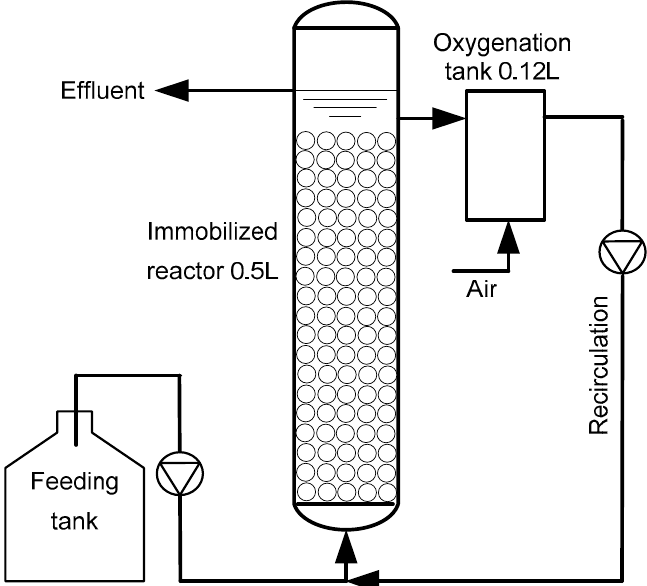
Figure 1. Schematic illustration of the immobilized cell biofilter treating diclofenac-based wastewater.